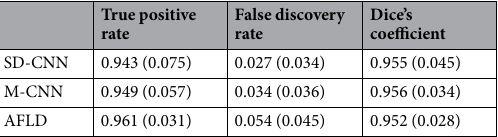
Table 3. Average performance of the SD-CNN, M-CNN, and AFLD methods with respect to manual marking across the split detector validation data set (standard deviations shown in parenthesis).